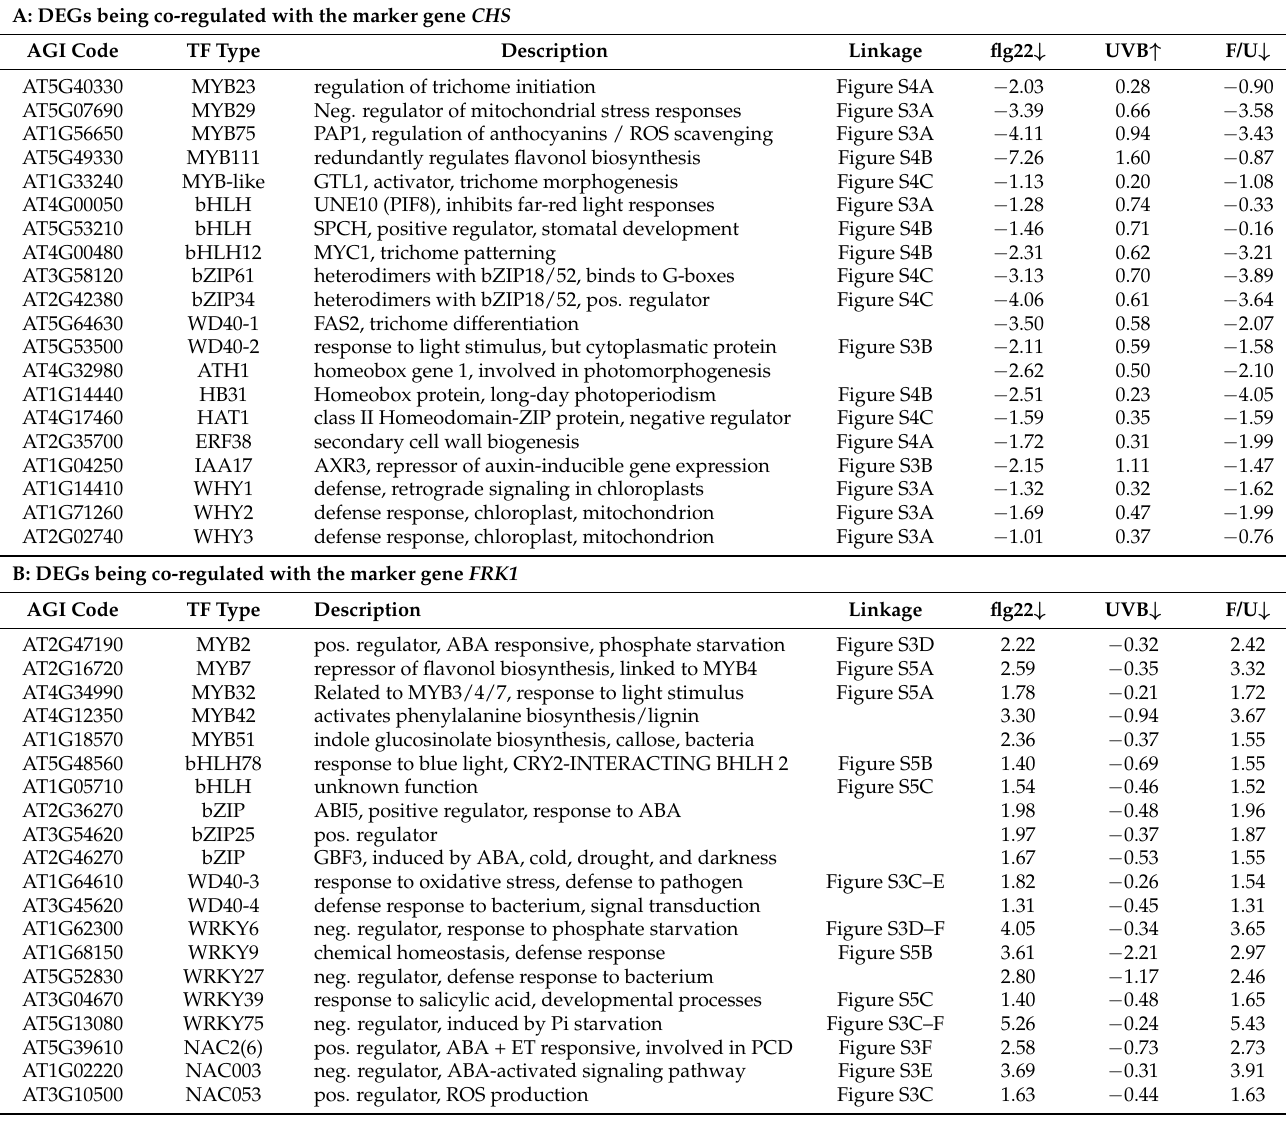
Table 2. Log2-values of top 20 candidate genes potentially involved in crosstalk between UV-B signaling and